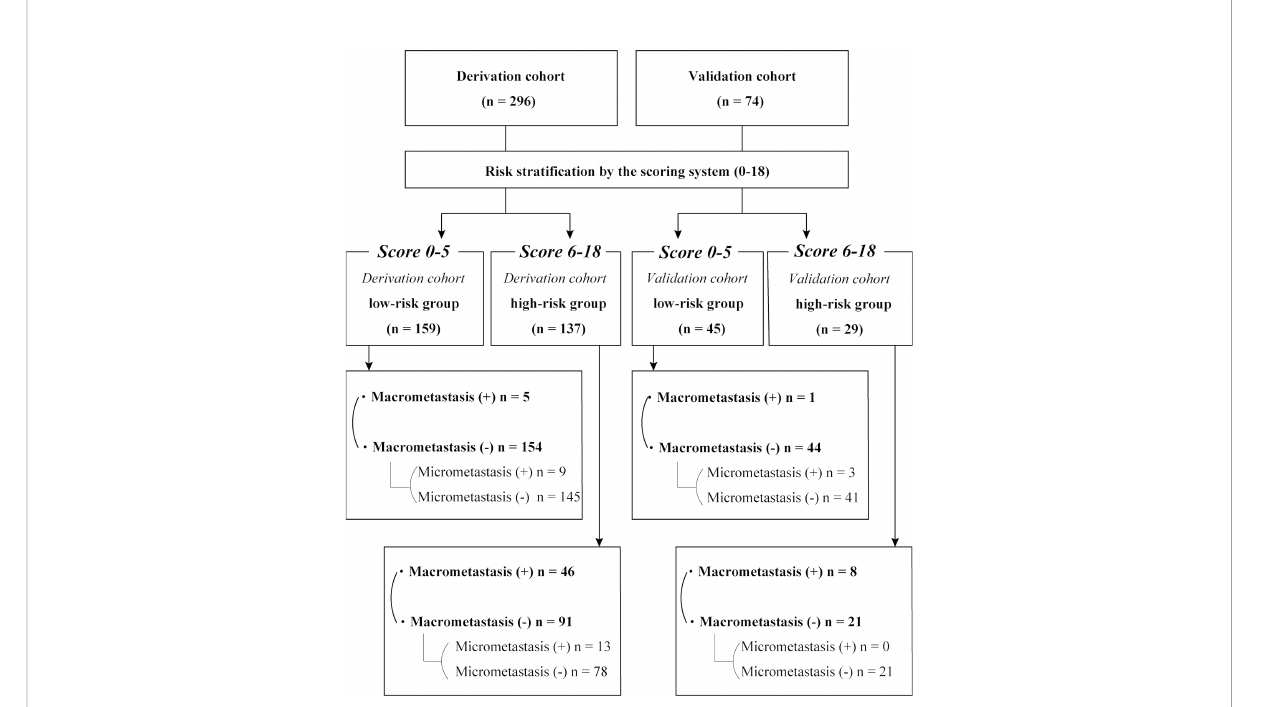
FIGURE 4 Results of the risk strati fi cation by the scoring system in the derivation and validation cohorts.